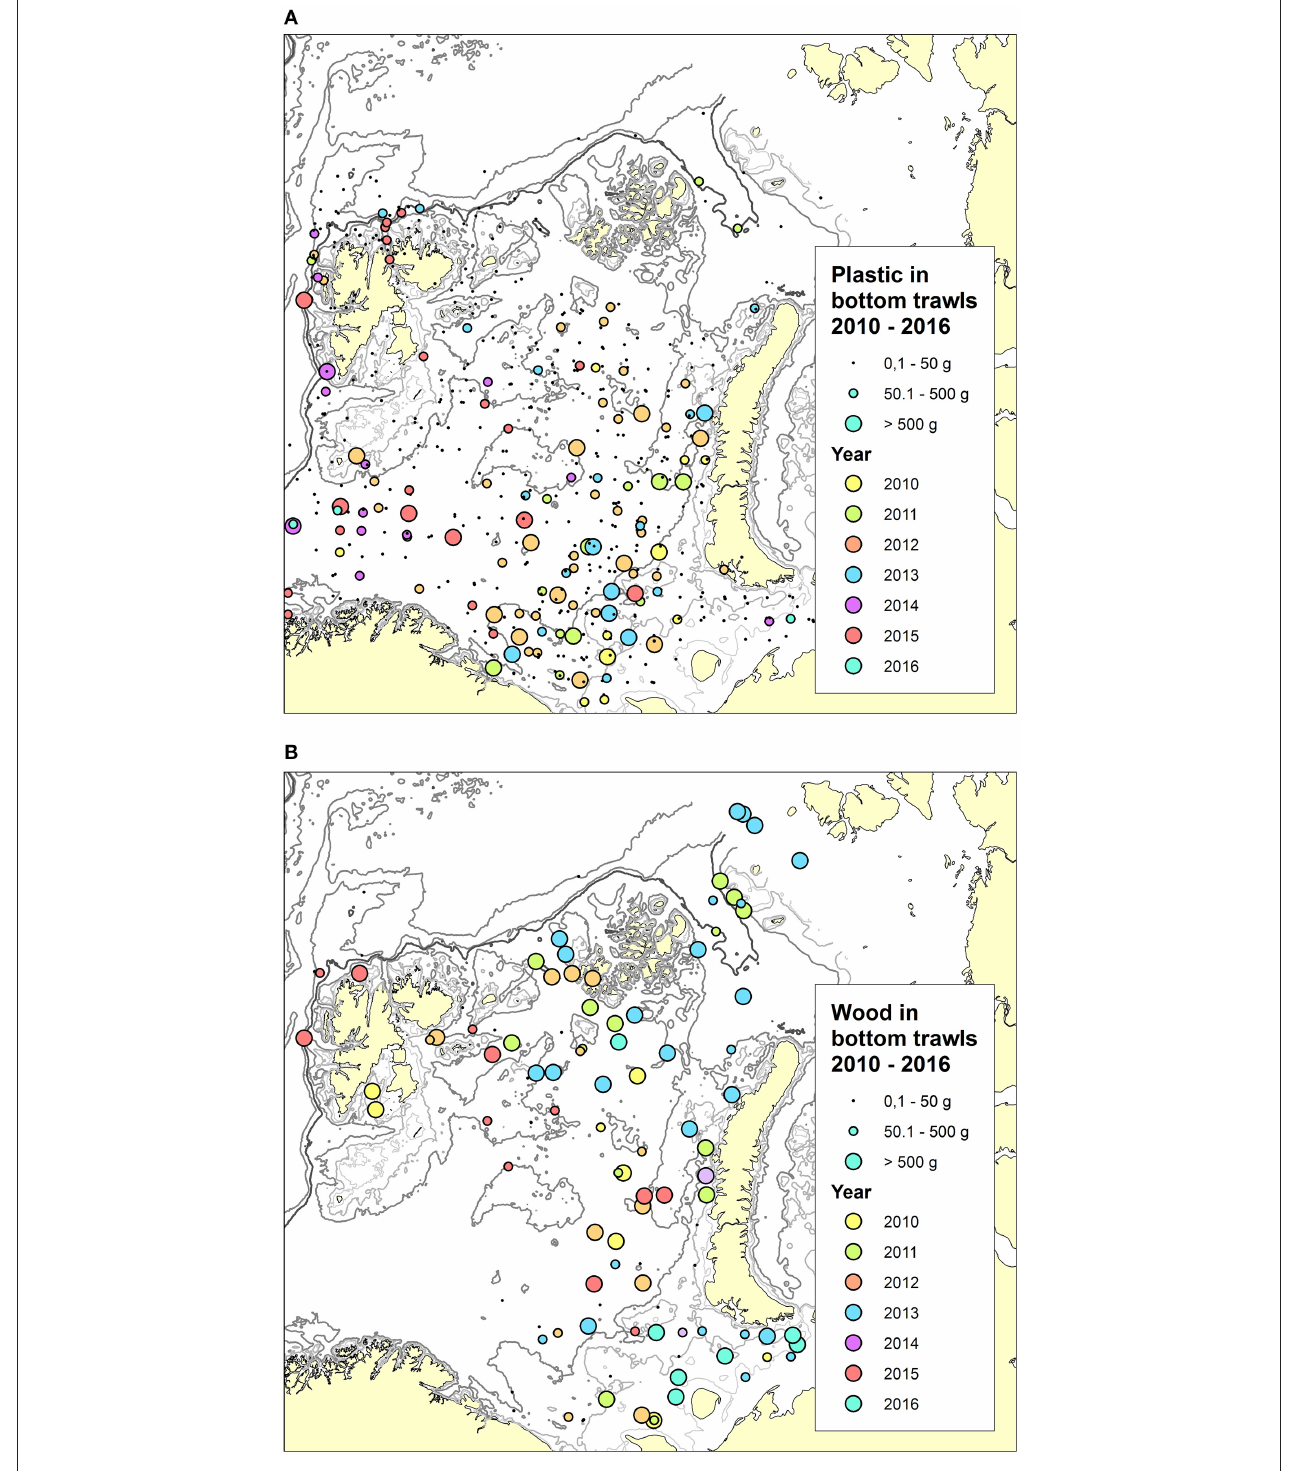
FIGURE 6 | Plastic and wood in bottom trawls from 2010 to 2016, (A) Plastic only. (B) Wood only. Different colors indicated per year.